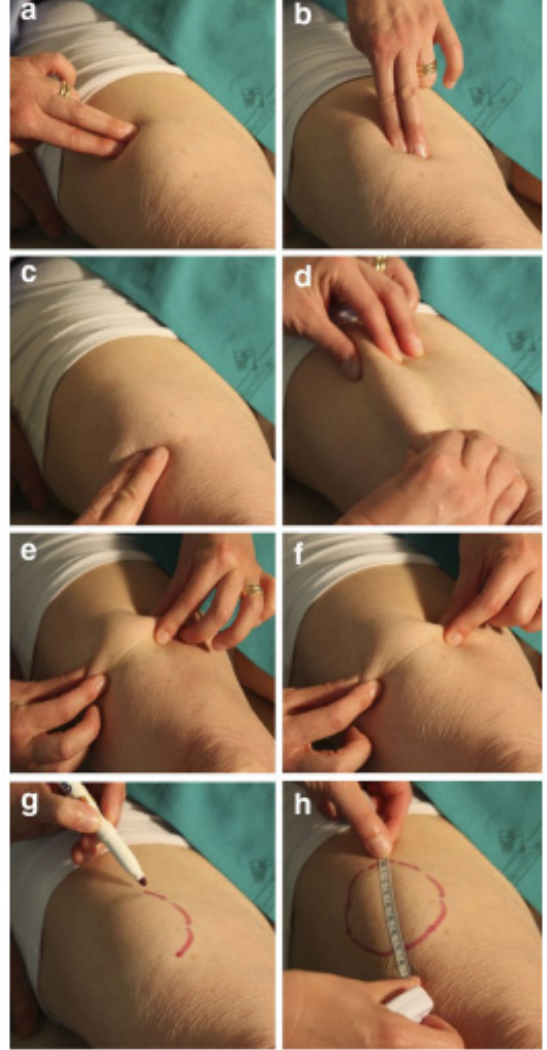
Figure 2. LH identification technique. The figure shows how to identify a lesion after a thorough inspection of the area by performing repeated vertical and horizontal fingertip movements over and around it ( a – c ), pinching it ( d – f ), and marking it ( g ), as well as how to finally measure it ( h ).